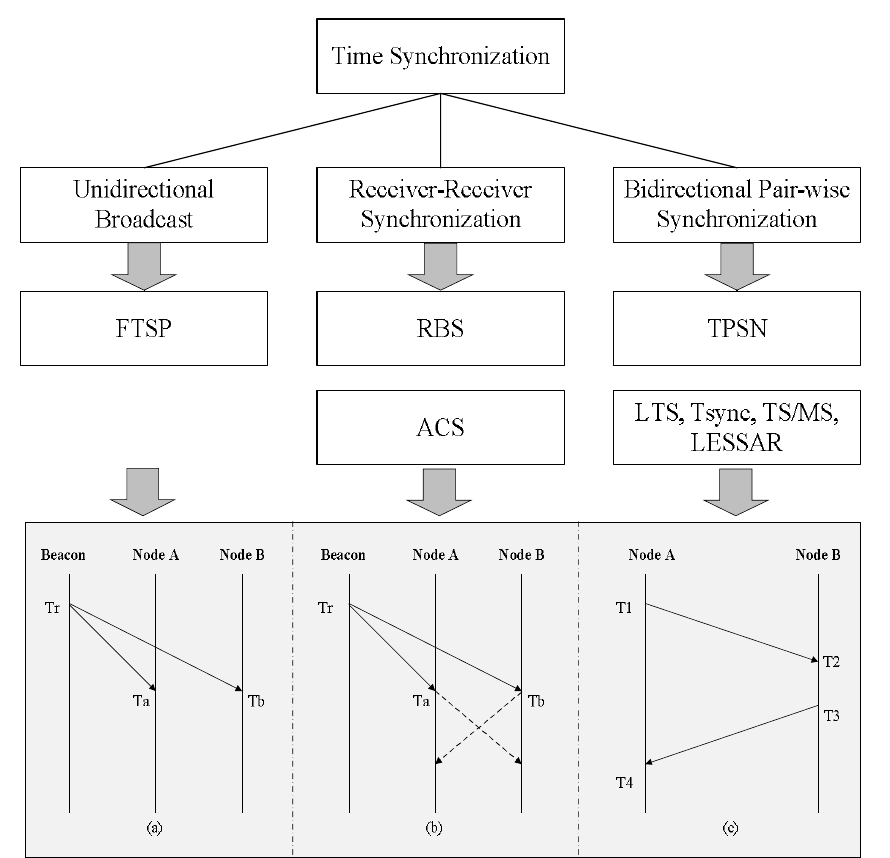
Figure 1. Classification of time synchronization